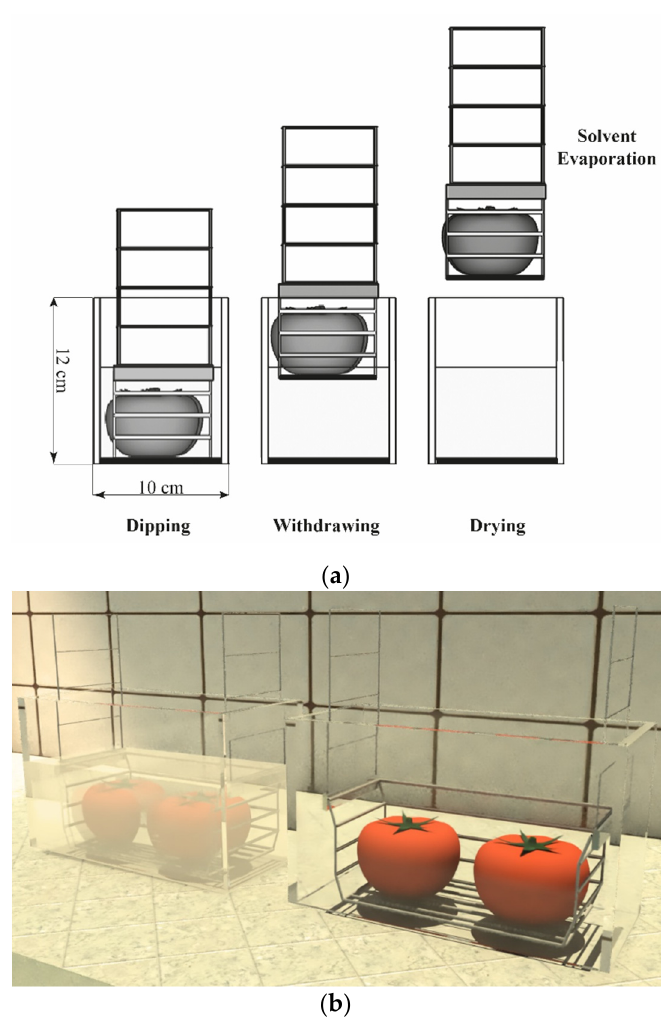
Figure 2. Design dip-coating cell, ( a ) A schematic view of the tomatoes dip-coating process, ( b ) a detailed picture of the cell.